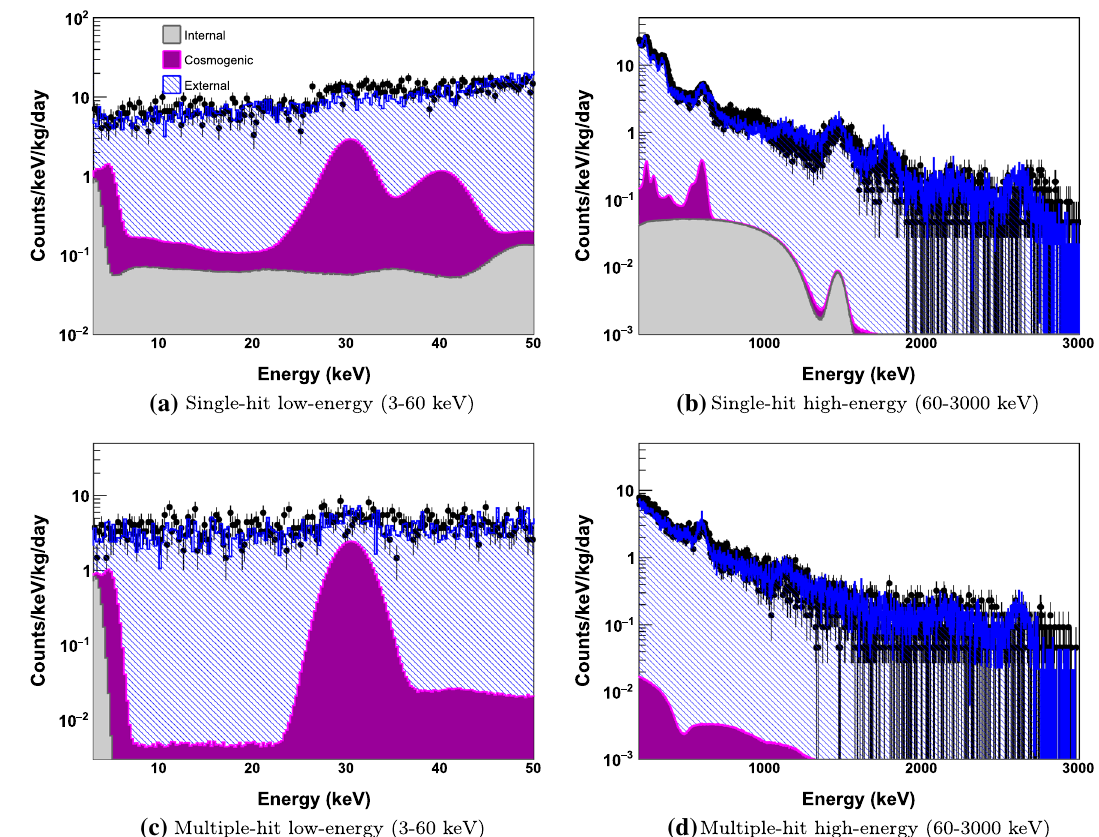
Fig. 11 Measured single-hit and multiple-hit background spectra of NaI-035 (black points) are determined for all simulated backgrounds using a simultaneous fit to the four-channels. The external component